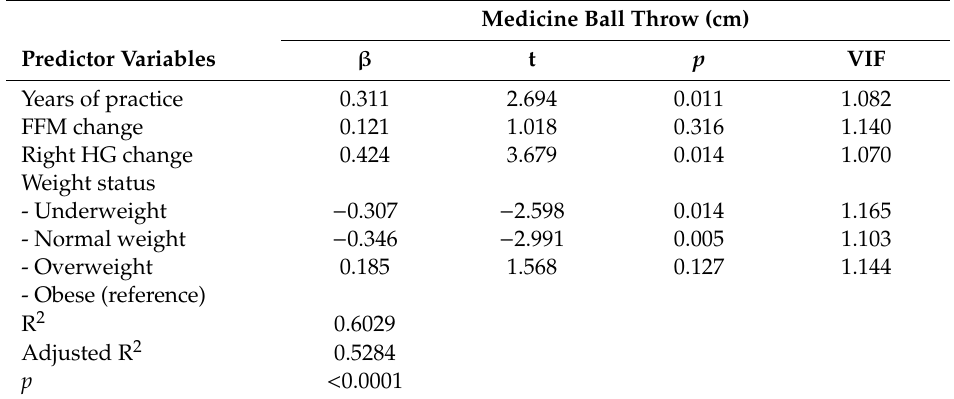
Table 4. Predictors of medicine ball throw: results of multivariate regression analysis. Medicine Ball Throw